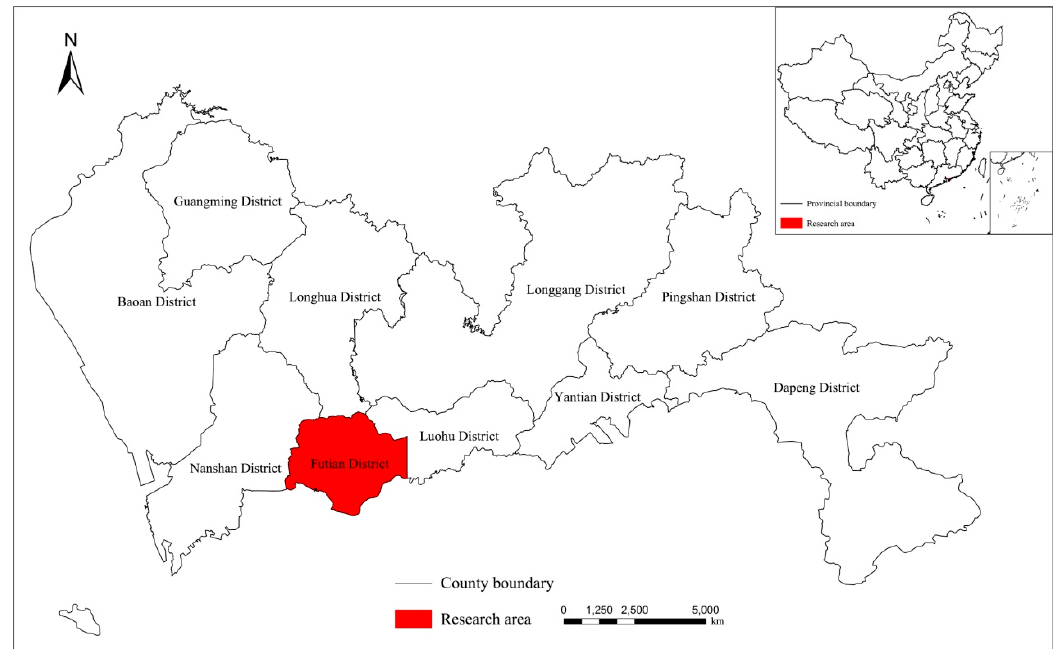
Figure 3. Location of Futian